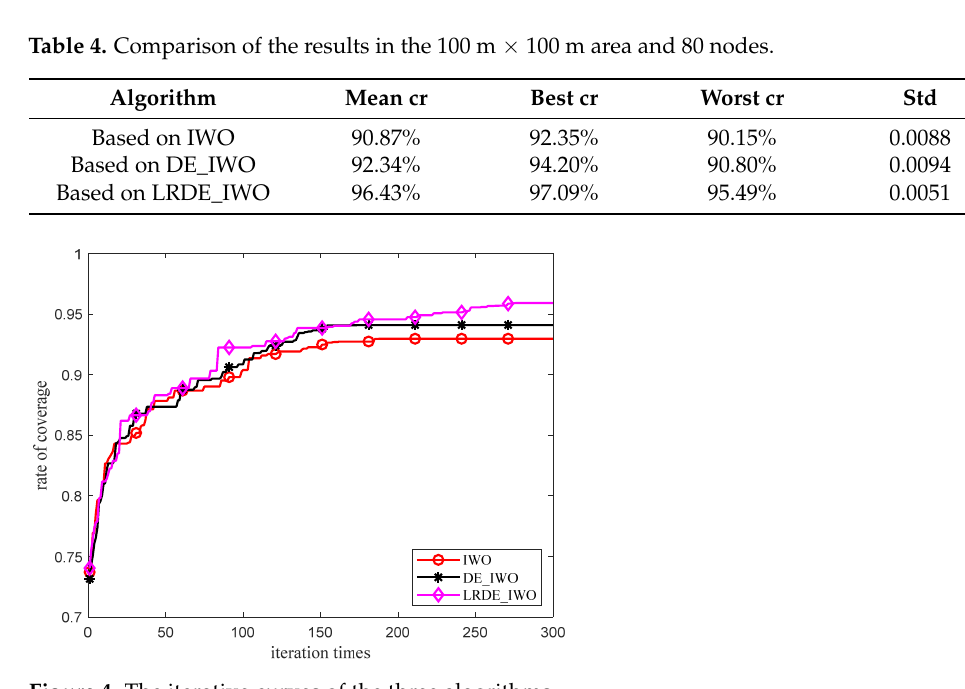
Figure 4. The iterative curves of the three algorithms.